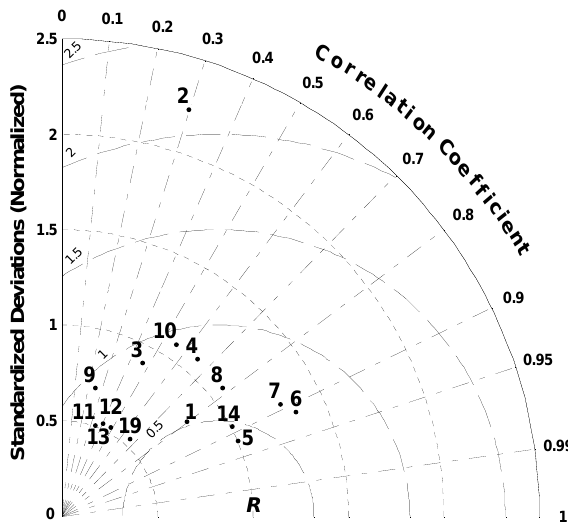
Fig. 4. Normalized pattern statistics showing differences between model and hydrographic observations of the neutral density bottom- layer ( γ n ≥ 28 . 27kgm − 3 ) in each cross-slope section as indicated (Sections 1 to 14 & 19; see Fig. 1a). The short-dashed curves, long- dashed curves, and long-short-dash radii refer to normalised stan- dard deviation, root-mean-square error and correlation, respectively. R = reference. WOD05 was the observed dataset used as reference (see the text for details).